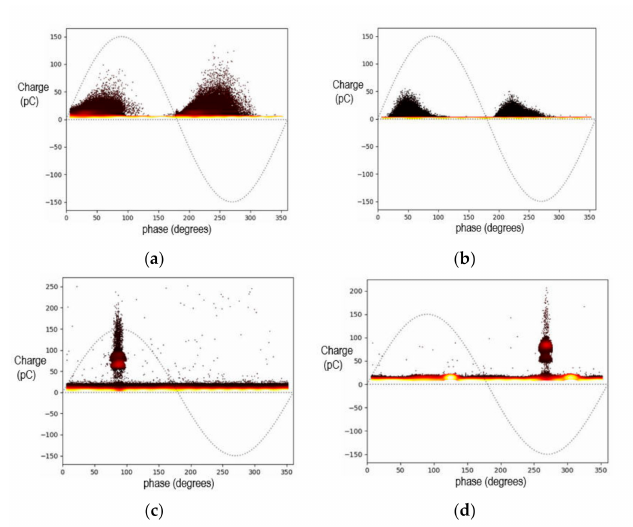
Figure 4. PRPDA of four PD types: ( a ) void, ( b ) surface, ( c ) low-voltage needle positive corona, ( d ) high-voltage needle negative corona.